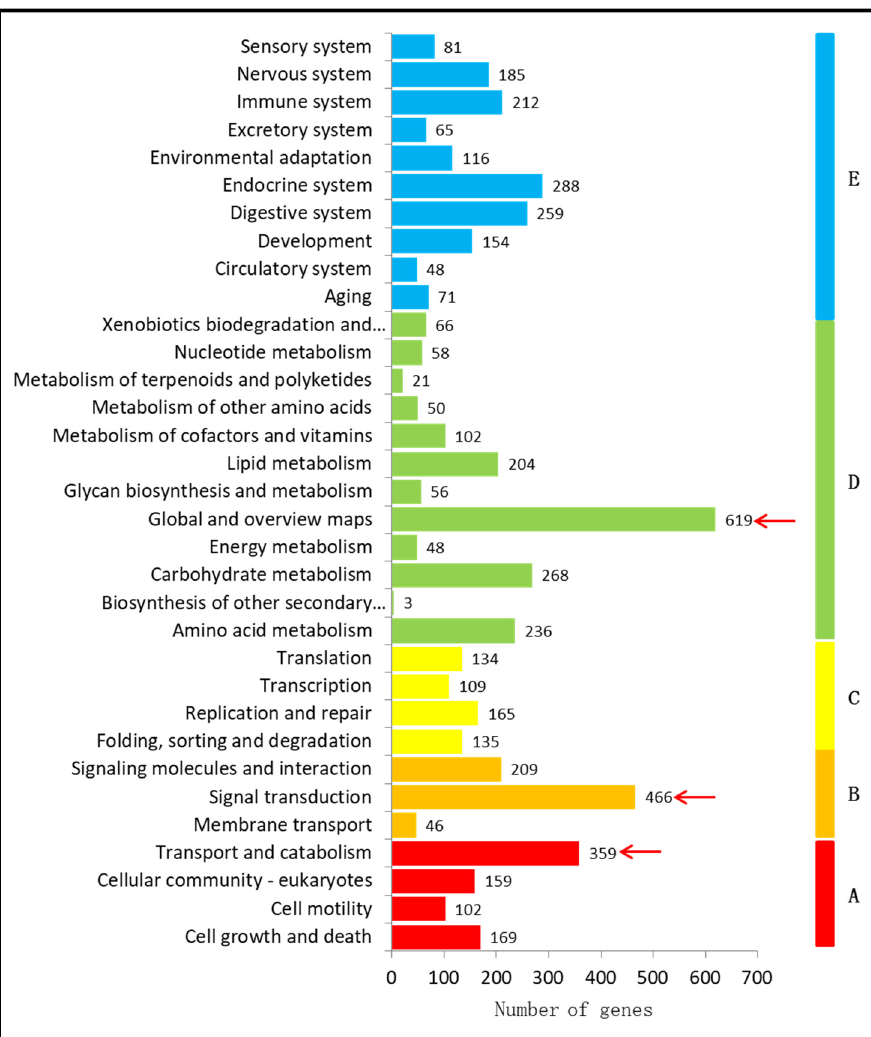
Figure 2. Histogram presentation of KEGG functional classification between G88 and Cry1S1000. The X -axis indicates the number of a specific category of genes, and the Y -axis is the enrichment of KEGG terms. Genes were classified into five branches: A—Cellular Processes; B—Environmental Information Processing; C—Genetic Information Processing; D—Metabolism; E—Organismal Systems. The red arrow indicates the pathway with more than 300 DEGs.